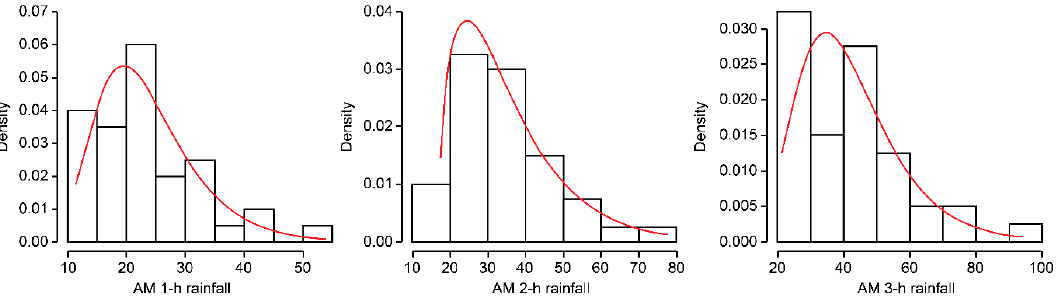
Figure 6. Marginal distributions of annual maximum 1-h, 2-h, and 3-h rainfall amounts.